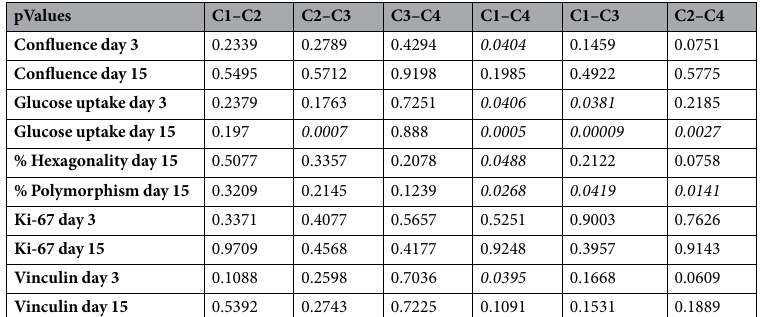
Table 1. Statistical data comparing different conditions and parameters. Numbers in italics indicate statistical significant difference. C1, C2, C3 and C4 indicate conditions 1, 2, 3 and